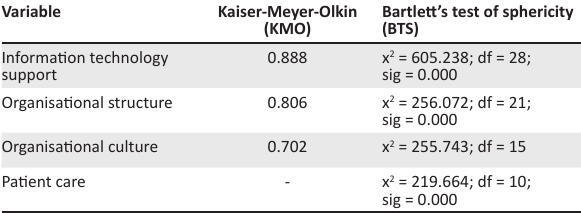
TABLE 4 : Kaiser-Meyer-Olkin and Bartlett’s test of sphericity.